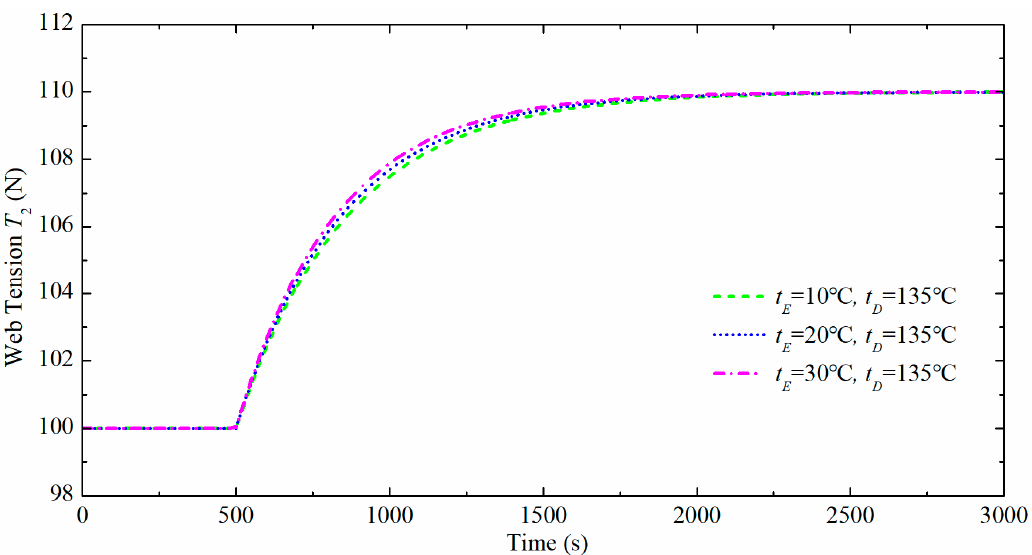
( ) T t as ( ) T t has step changes at different room 2 1